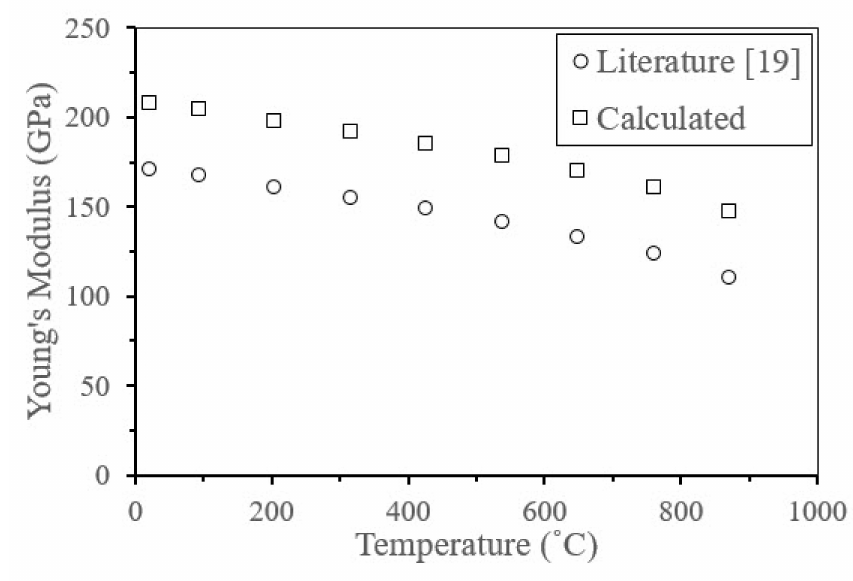
Figure 41. Elastic modulus variation with